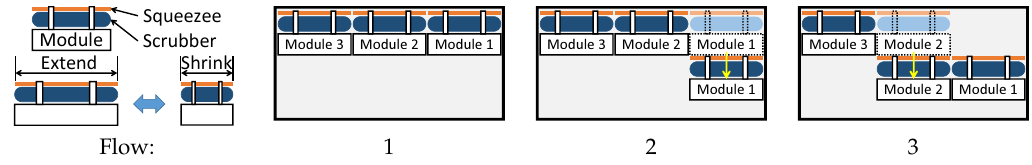
Figure 4. Module’s strategy of transition to accomplish the cleaning task. Since the squeegee is installed next to the scrubber, and the glass surface is cleaned by the movement from top to